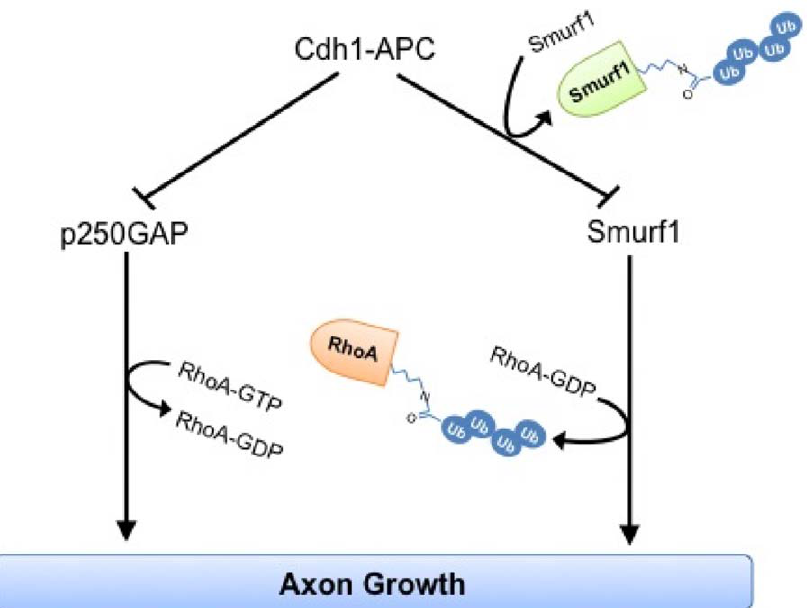
Figure 7. Schematic of Cdh1-APC-regulated axon growth. The E3 ubiquitin ligase Cdh1-APC operates upstream of the RhoA-regulating proteins Smurf1 and p250GAP in the control of axon growth. While Cdh1-APC ubiquitinates Smurf1 for proteasomal degradation, it ubiquitinates p250GAP for a functional modification in RhoA-dependent axon growth inhibition.